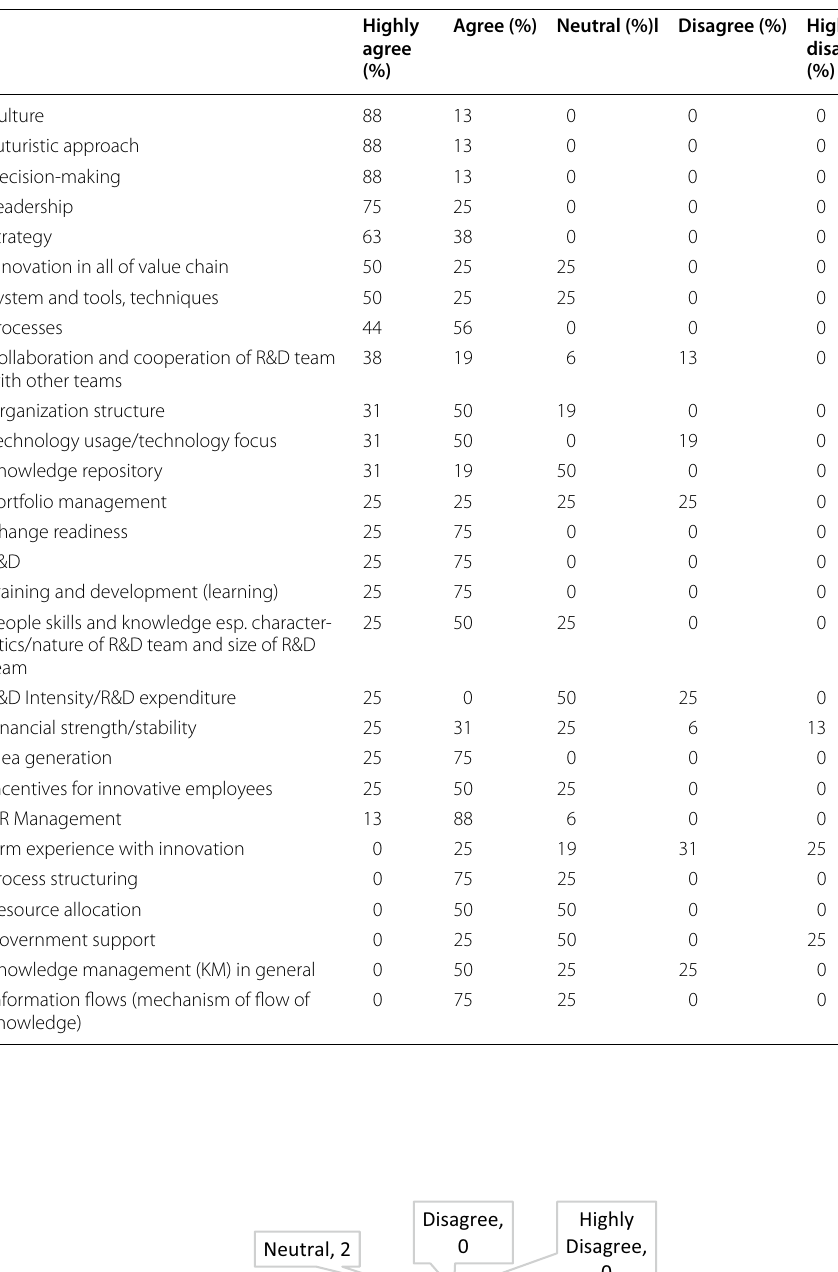
Table 3 Survey results in percentage of response related to organizational factors